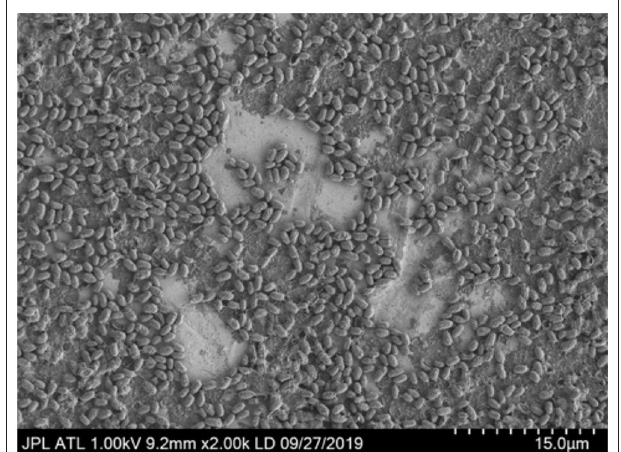
FIGURE 3 | An electron microscope image of Bacillus canaveralius 29669 spores used to measure the spore size. 2 × 10 6 spores per coupon were added before drying and lyophilizing. Based on the overlap in the image as well as a measured 10% coffee ring experience from 4 × 10 6 spores/coupon dried on Kapton ( Supplementary Figure 6 ), a minimal coffee ring effect is expected for the IR exposure experiments. 15 µ m is the distance from the farthest left and farthest right hash on the bottom-right side of the